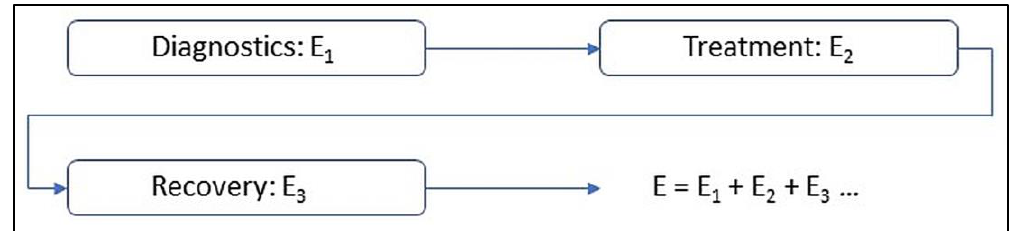
Figure 1. Single-link diagnostics and treatment